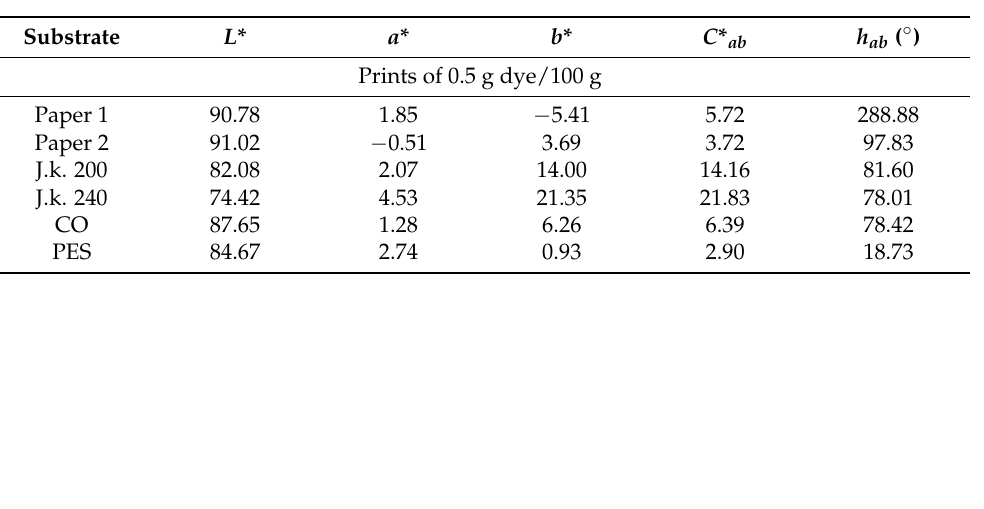
Table 1. Color values of prints with different dye concentrations on papers and